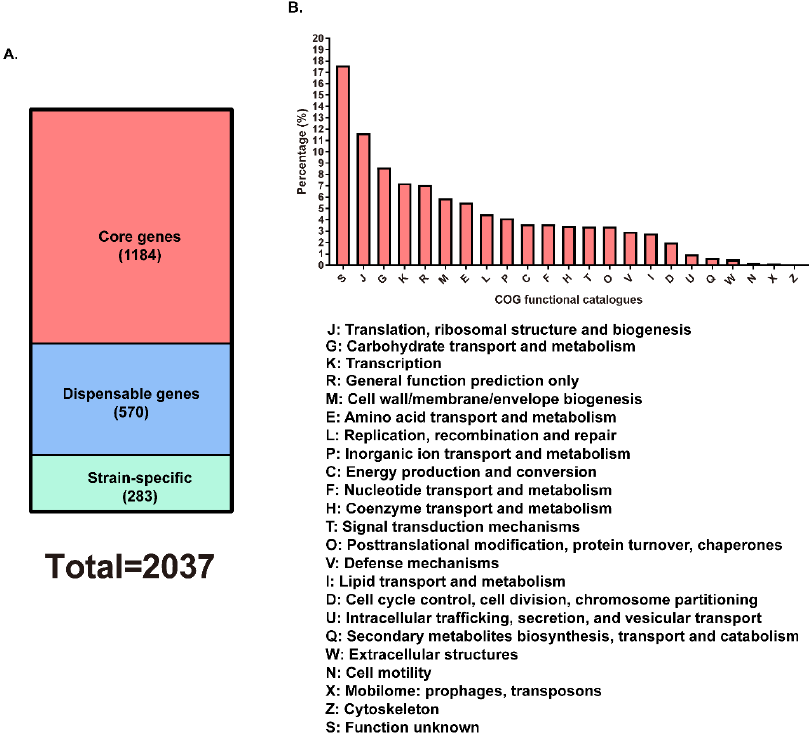
Figure 4. Distribution of core and dispensable genes among the eight E. rhusiopathiae virulent strains. ( A ) Distribution of core and dispensable genes. ( B ) COG functions of the core genes predicted.